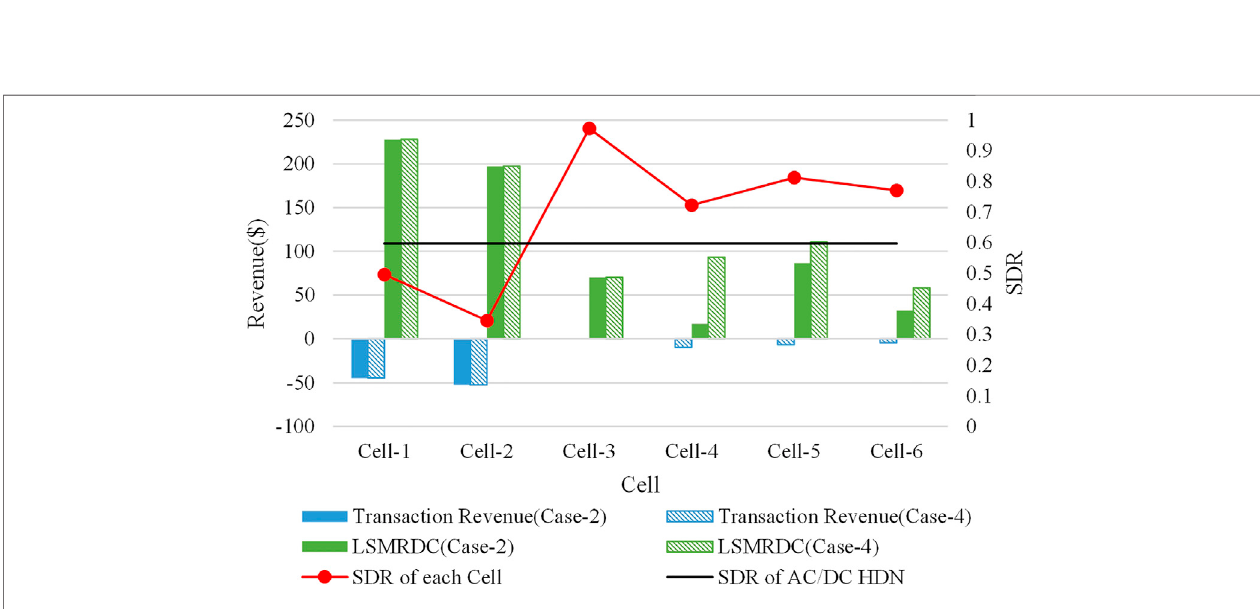
FIGURE 8 | SDR, transaction revenue, and LSMRDC for each Cell at the 15:00.